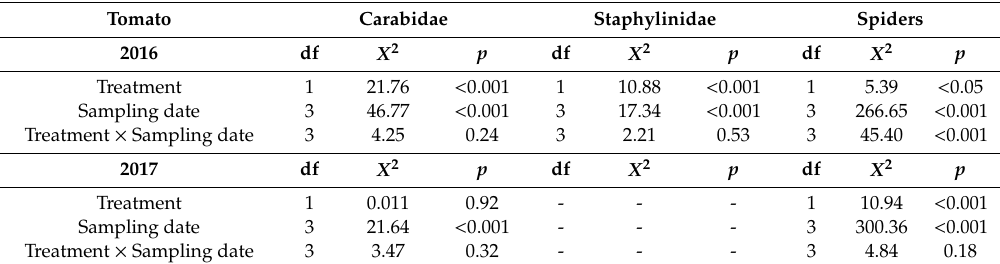
Table 4. Statistics of the model e ff ect for the negative binomial General Linear Mixed Model carried out on the number of individuals Carabidae, Staphylinidae, and Araneae in tomato plots. Staphylinidae in 2017 were not analyzed because of the limited number of caught